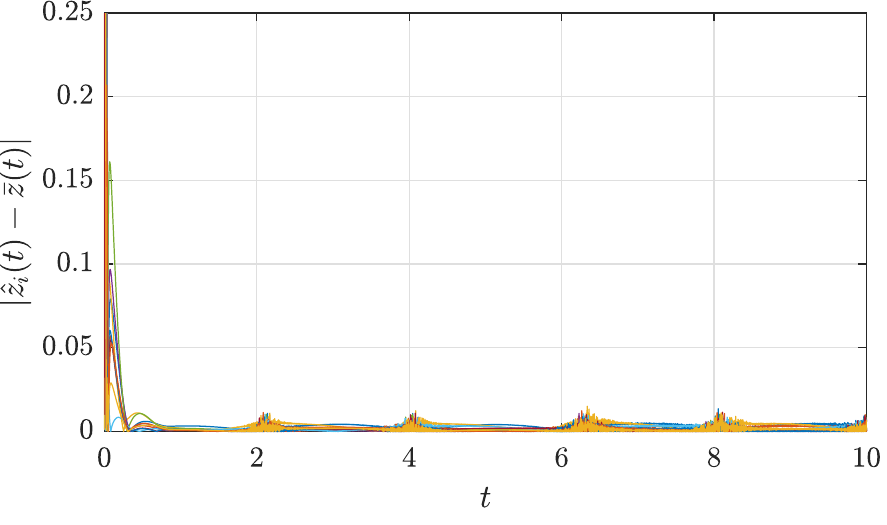
Figure 4. Consensus error for our protocol with ∆ = 10 − 4 , ε = 0.01. The addition of event-triggered communication increases the steady-state consensus error with respect to the full communication case (see Figure 3) and can be tuned with ε